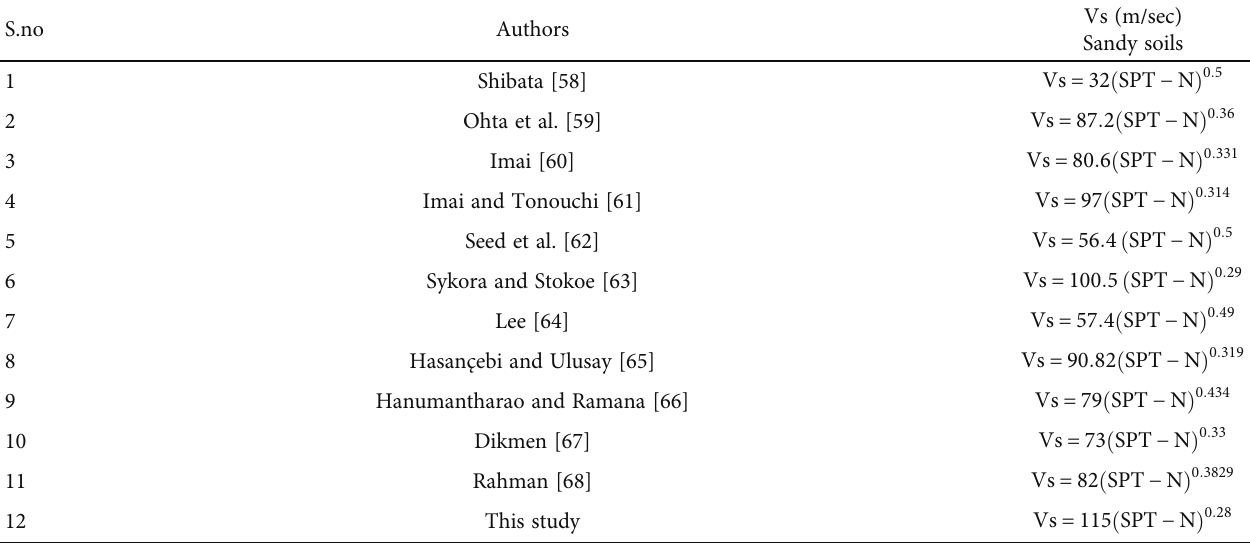
Table 3: Existing empirical correlations between Vs and SPT-N values employed for this investigation depending on the soil type from the other experts.